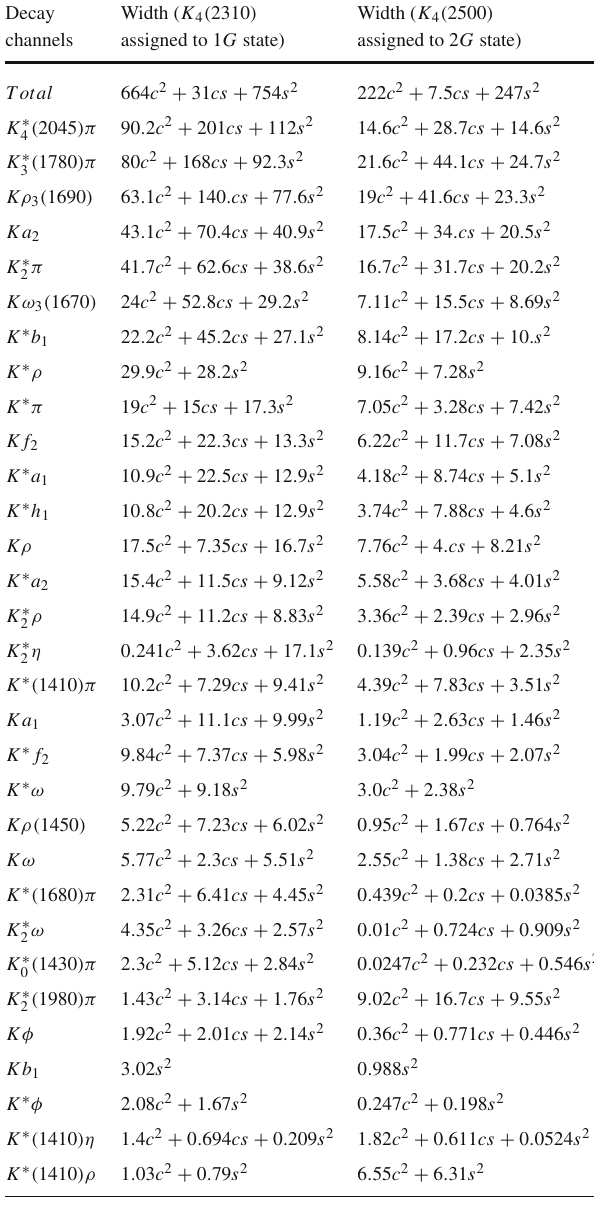
Table 14 The main strong decay widths of K 3 ( 2360 ) assigned to an 2 F (cid:5) state, where s and c represent sine and cosine functions. The unit of the width is MeV